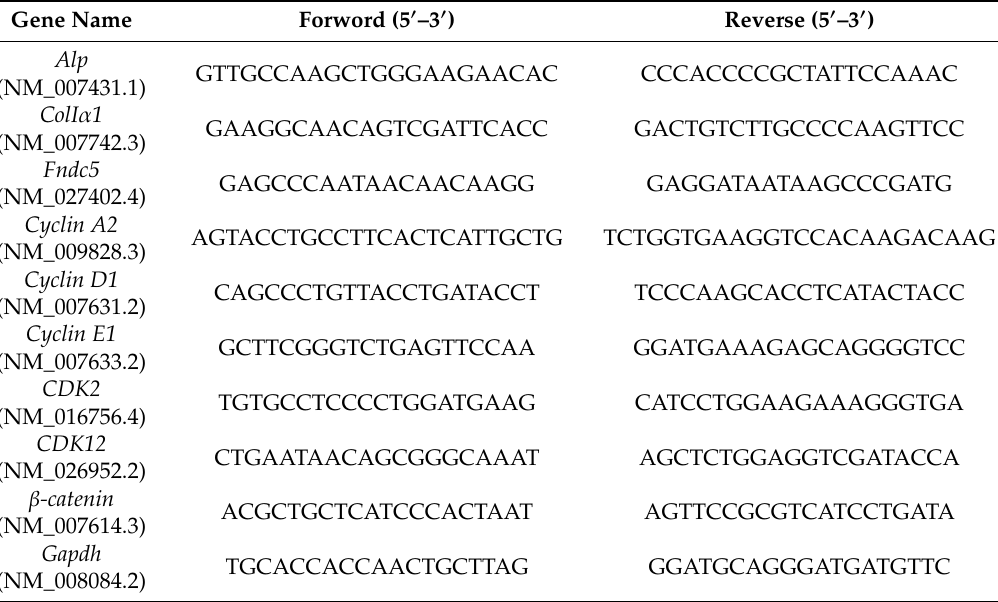
Table 1. The primer sequences for real-time